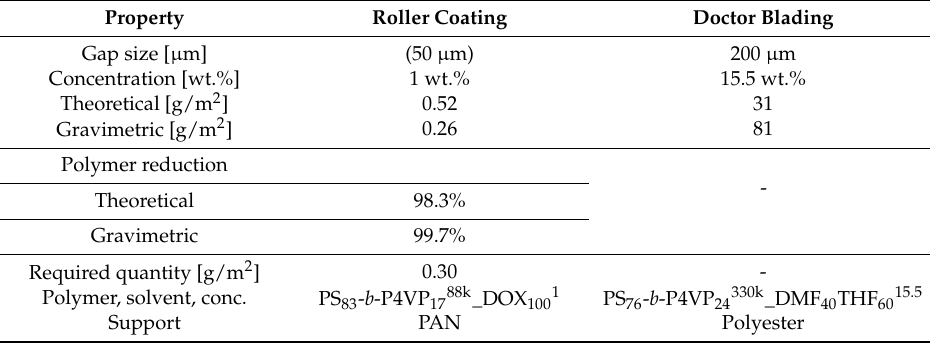
Table 2. Polymer consumption per unit area of a roller coated PS 83 - b -P4VP 1788k _DOX 1001 in